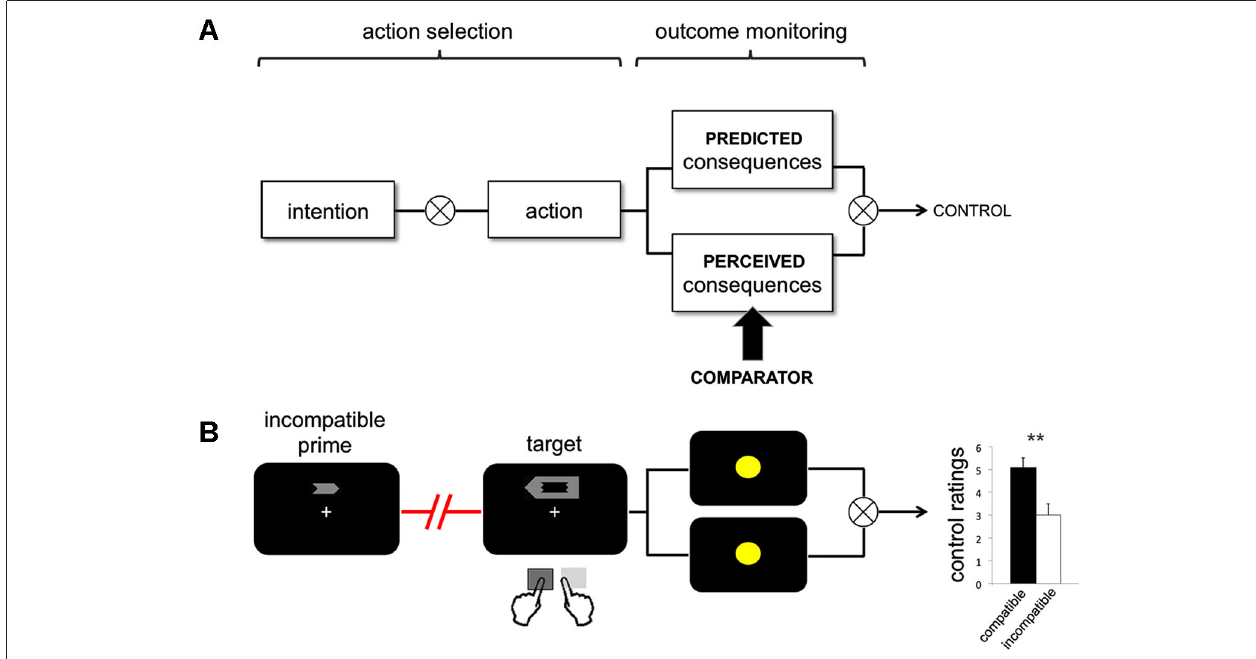
and is reduced in the case of a mismatch. (B) Example trial from the prime-target incompatible condition, adapted from Chambon et al. (2013). Participants were instructed to respond to the target stimulus, and were not informed of the presence of the arrow primes. Action effects consisted of colored circles that appeared on the screen after a varying delay. In this condition, sense of agency decreases relative to the compatible condition, even though predicted and perceived action effects are the same (yellow